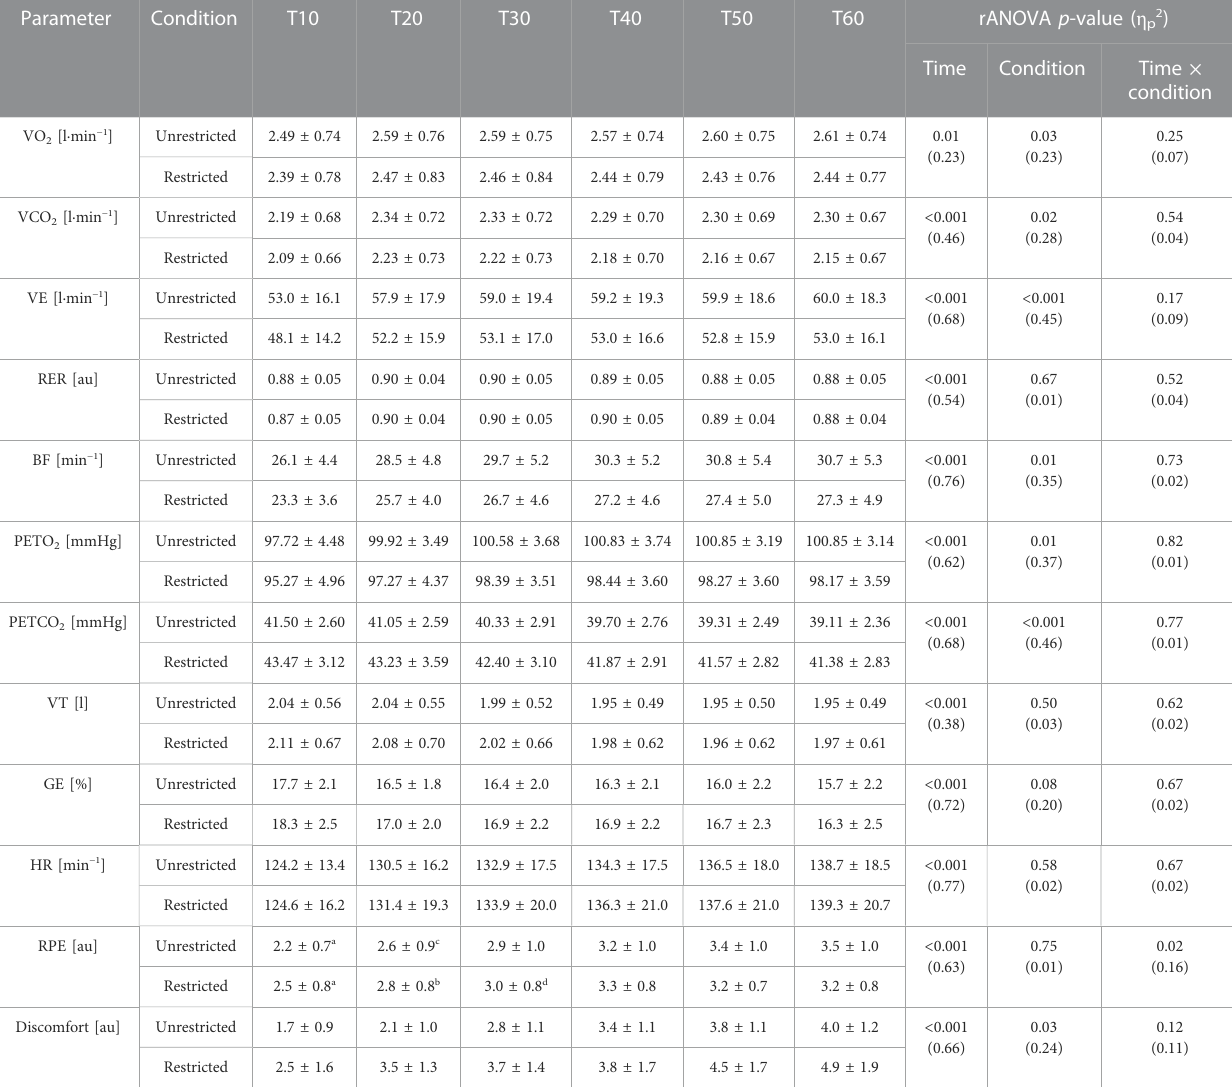
TABLE2Performancedata(meanvalue±standarddeviation)fortherestricted(nasal-only)andunrestrictedconditionateach10mininterval(T10-T60)foroxygen uptake (VO 2 ), carbon dioxide release (VCO 2 ), total ventilation (VE), respiratory exchange value (RER; VCO 2 divided by VO 2 ), breathing frequency (BF), end tidal pressure of oxygen (PETO 2 ), end tidal pressure of carbon dioxide (PETCO 2 ), tidal volume (VT), gross ef fi ciency (GE; work accomplished divided by energy expenditure and multiplied by 100), heart rate (HR), perceived effort (RPE), and discomfort. p -Values and partial eta squared ( η p 2 ) of rANOVA are also